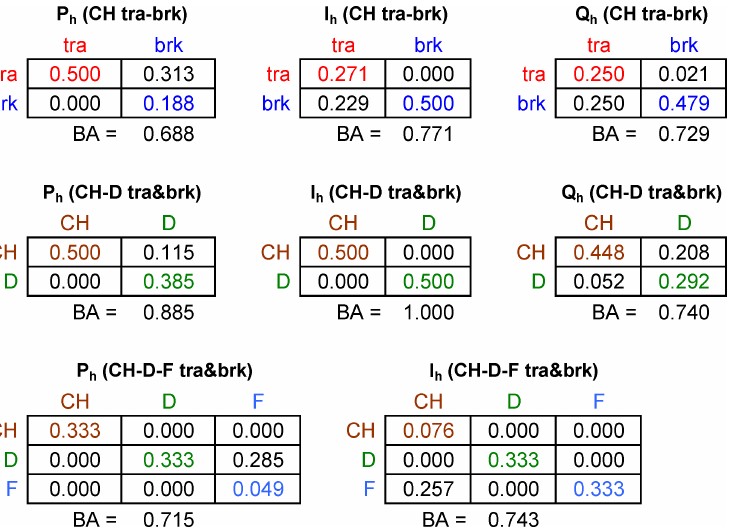
Figure 17. Confusion matrices and balanced accuracy BA for PLSR using the GMM algorithm: 24 observations used for each rs (CH, D, and F train) and oc (traction and braking) for a total of 144 spectra; comparisons were carried out for traction/braking conditions within the same system (selected CH), for different rs for more similar systems (CH and D), and the same for all three different systems (CH, D, and